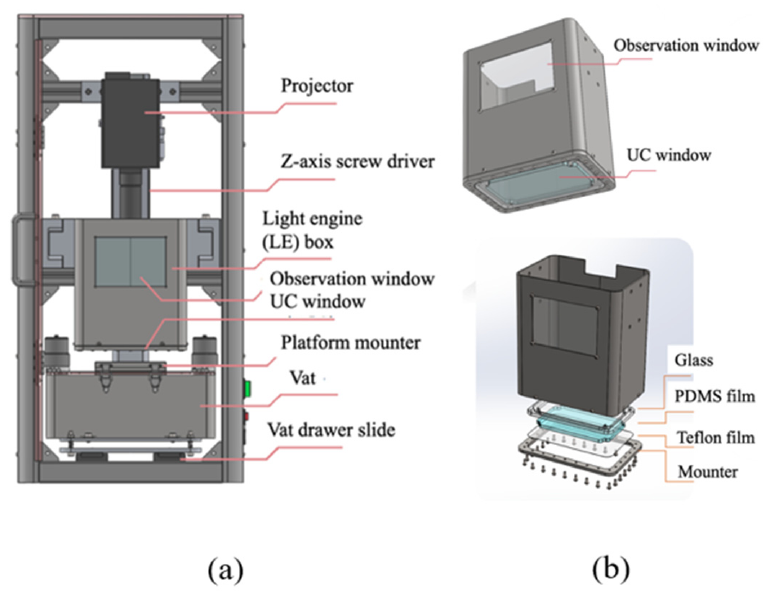
Figure 2. The mechanical design of the proposed printer ( a ) and the disassembled components of b the LE box ( b ). LE box (